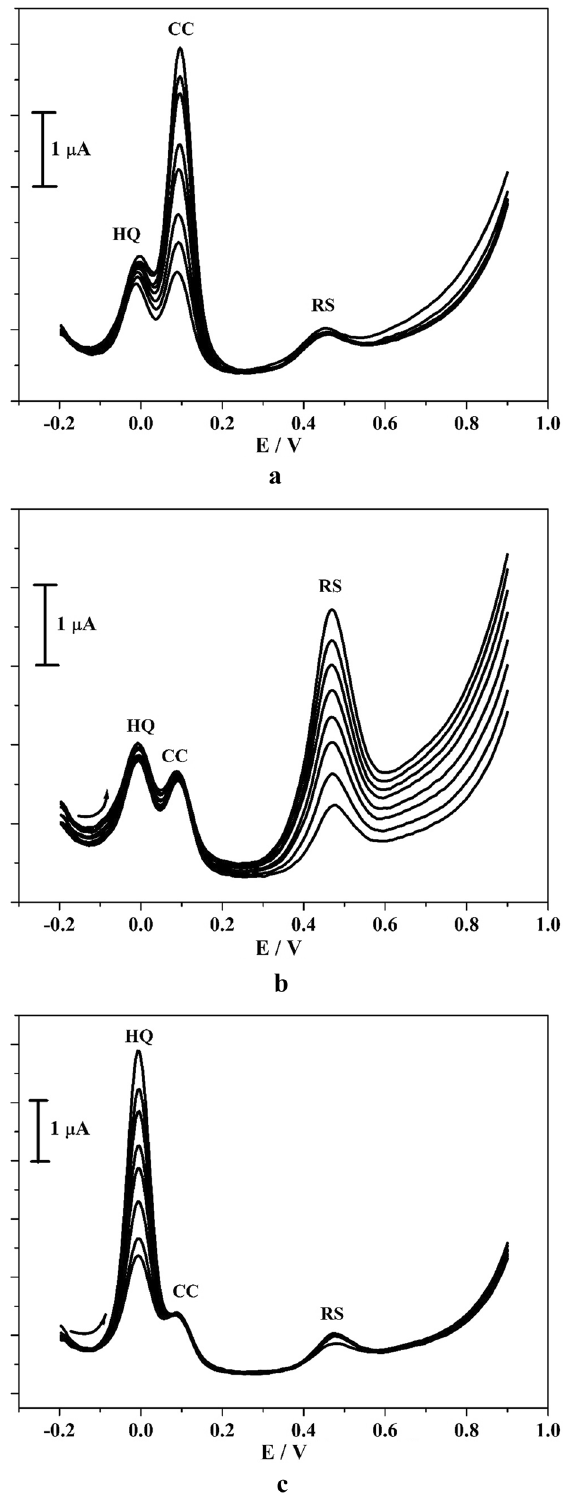
Figure 12. ( a ) DPVs curve for CC with various concentration (100–800 µM) in presence of HQ and RS (10 µM). ( b ) DPVs curve for RS with various concentration (100–800 µM) in presence of CC and HQ (100 µM). ( c ) DPVs curve for altered concentartion of HQ (100–800 µM) in presence of RS and CC (100 µM) in 0.2 M PBS (pH 7.4) at poly(CBBG)/MCPE with scan rate 50 mVs -1